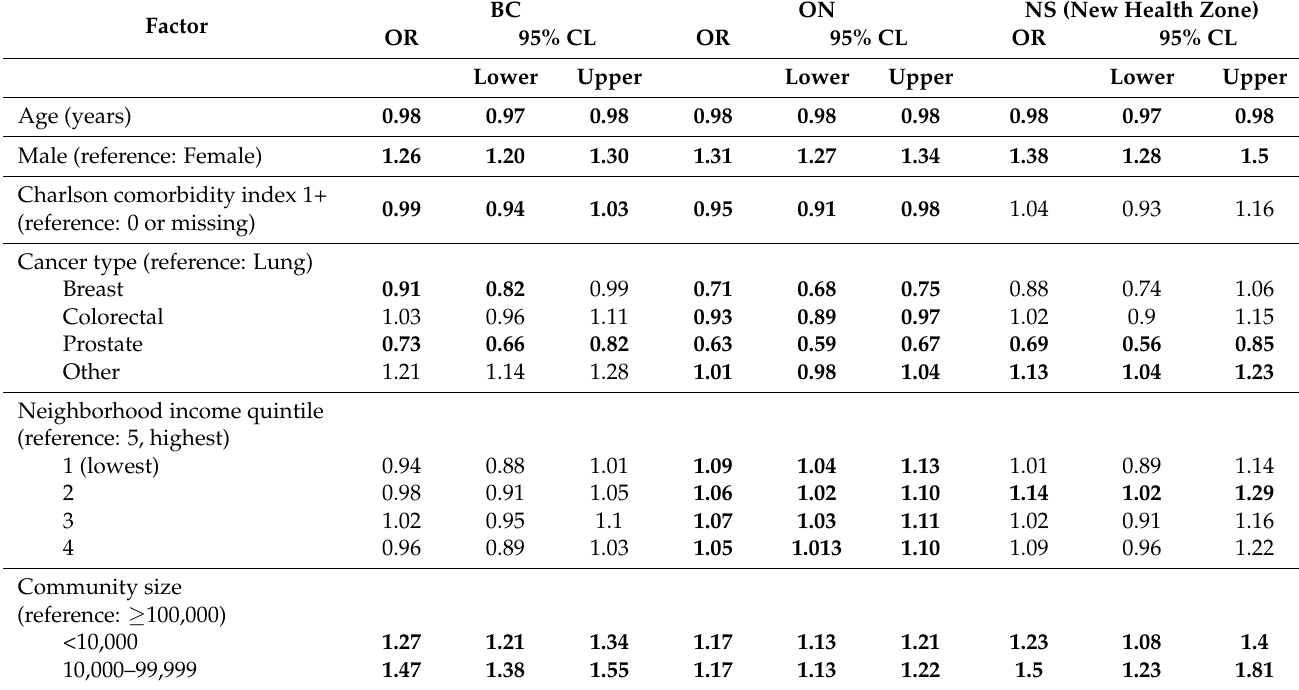
Table A3. Multivariable logistic regression model for aggressive care, 2004–2015.